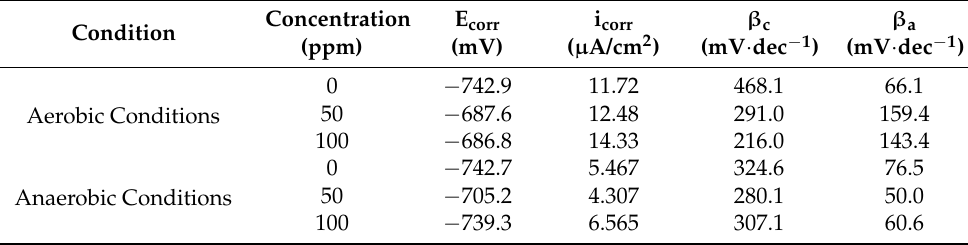
Figure 6. Potentiodynamic polarization curves of samples under aerobic ( a ) and anaerobic ( b ) conditions. Table 3. Electrochemical parameters fitted by the potentiodynamic polarization curves.